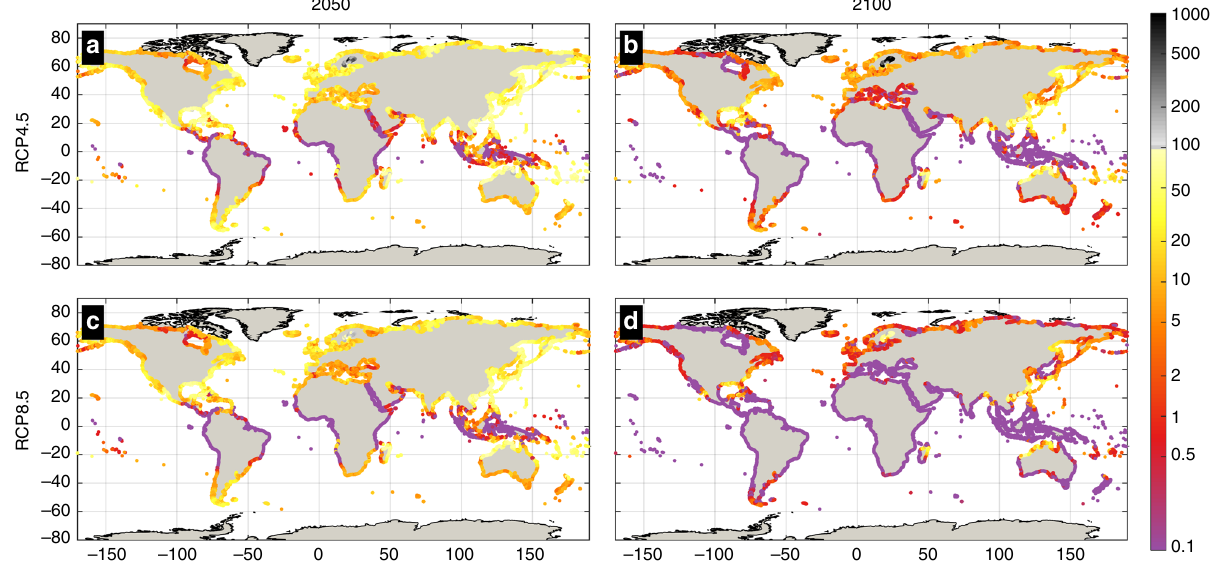
Fig. 8 Future frequency of the present day 100-year ESL. Colors show the return period of the present day 100-year ESL under RCP4.5 and RCP8.5 in 2050 ( a , c ) and 2100 ( b , d ), based on the median values. Note that the color scale is not